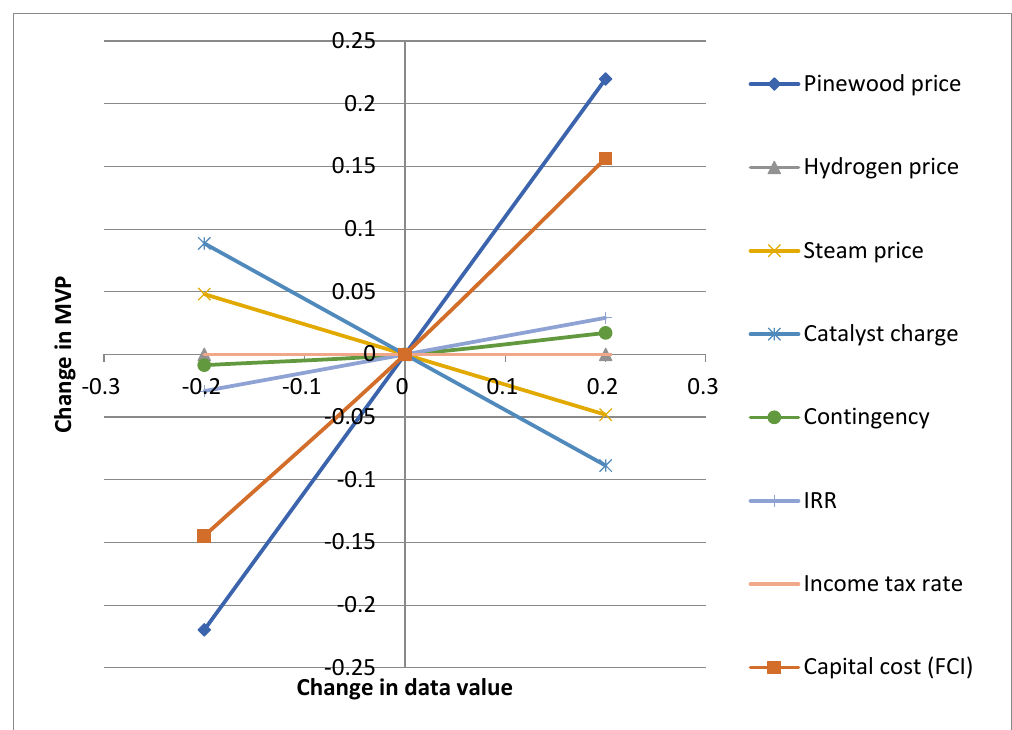
Figure 3. Sensitivity of minimum viable price to 20% variation in data inputs for the completely hydro-treated oil using a catalyst of Cs/amorphous silica alumina (HT_Oil_Cs/ASA) case. Processes 2020 , 8 , x FOR PEER REVIEW